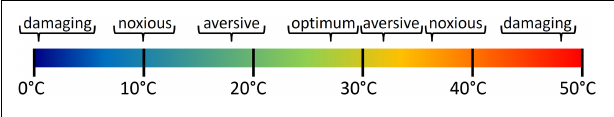
FIGURE 1 | Effect of temperature on wellbeing of zebrafish larvae. Dependent on age and exposure time of larvae or adults temperatures outside the optimal range of around 23–30 ◦ C became increasingly aversive, noxious and damaging with rising heat or cold. Temperatures of 10 or 34 ◦ C have been described as noxious and are damaging at 0 or 48 ◦ C within